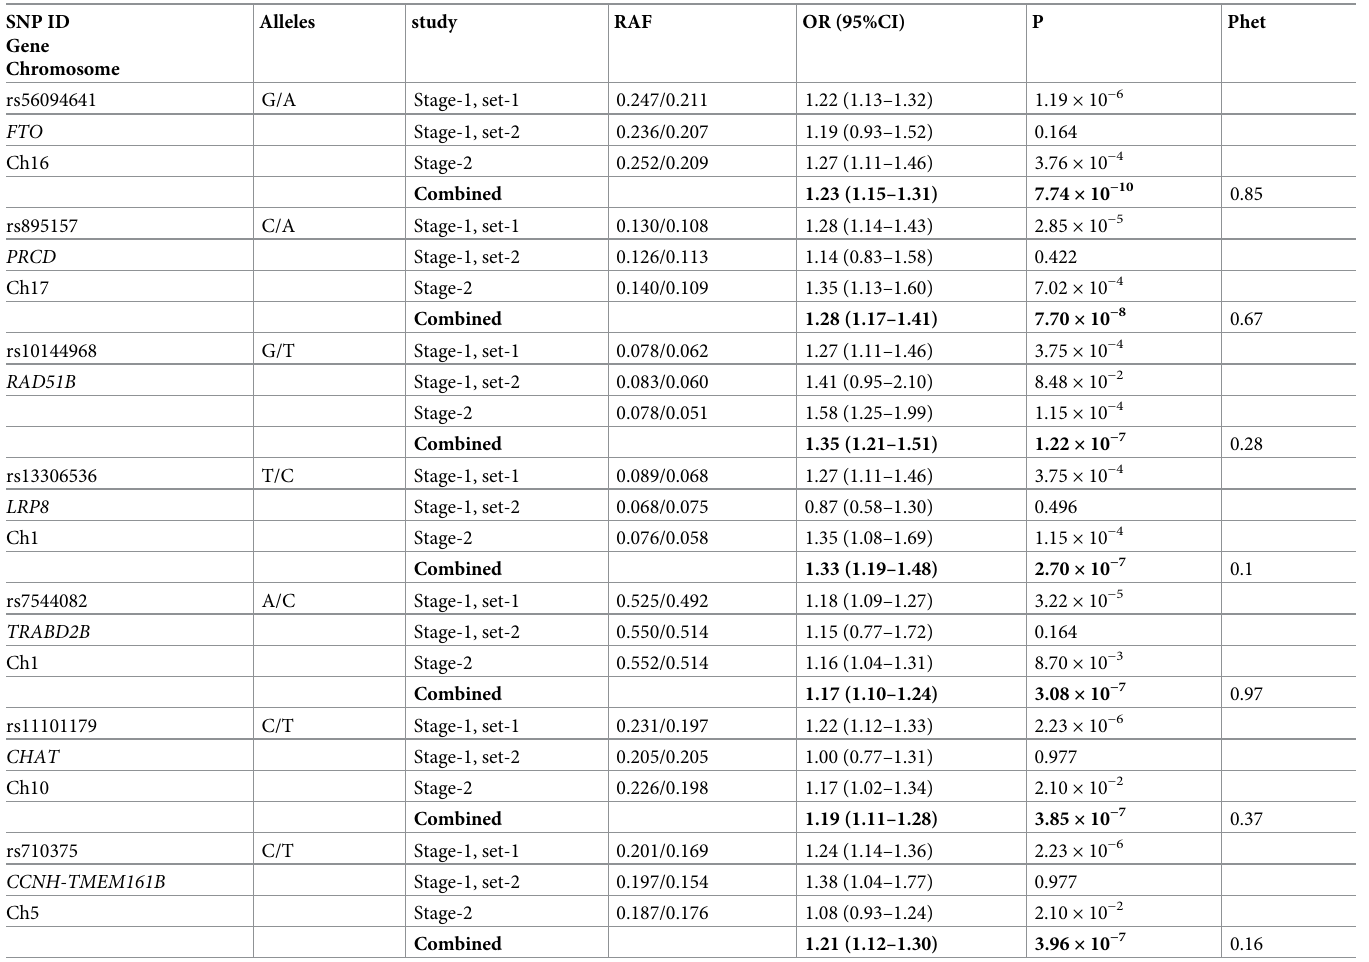
Table 2. Association of 7 SNP loci with diabetic nephropathy in Japanese patients with type 2